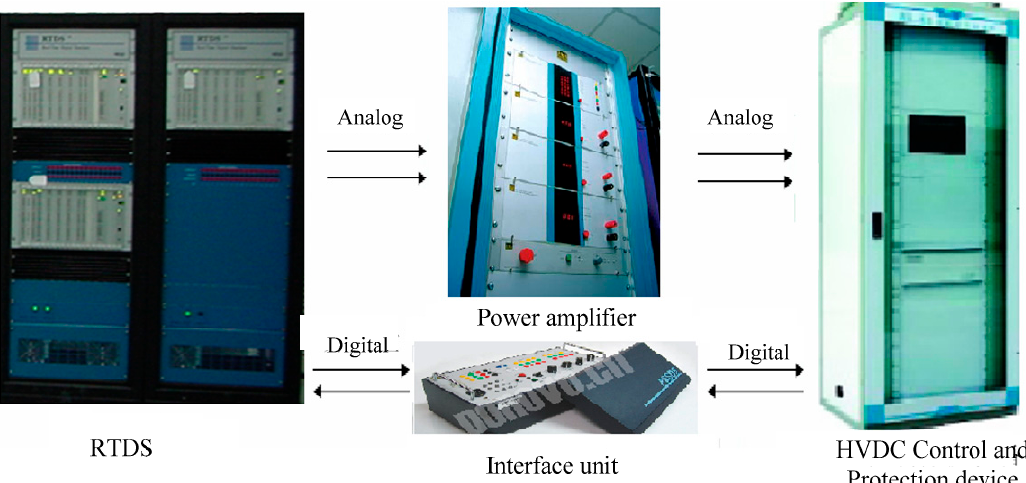
Figure 10. The real-time digital simulator experimental system.